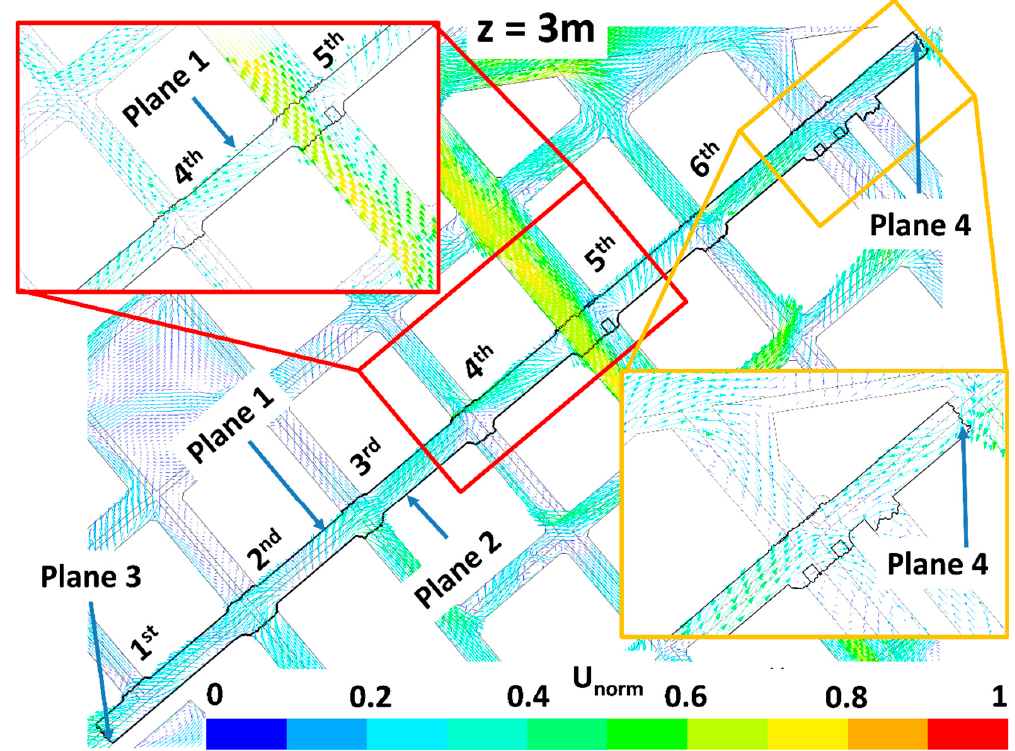
Figure 7. Same as Figure 6 but for the LAD05 scenario.